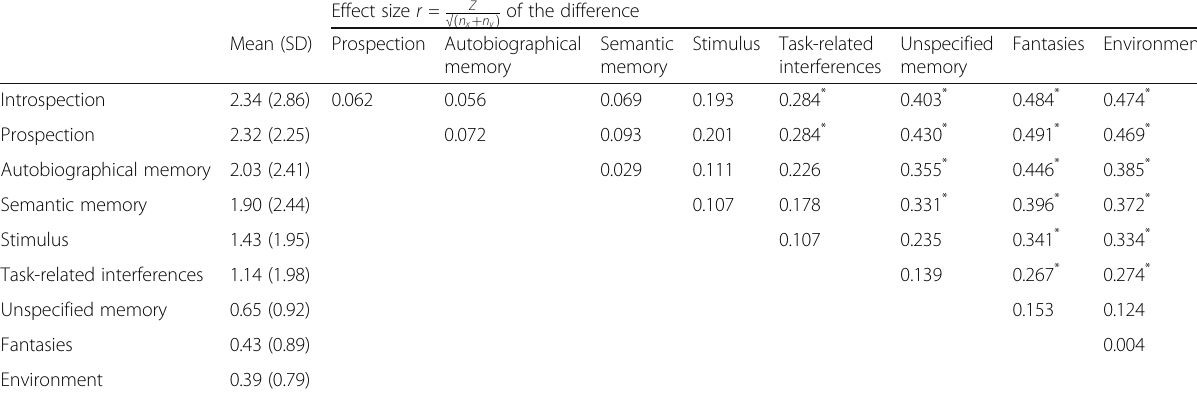
Table 2 Pairwise-comparisons between the frequencies of thought categories across participants using Wilcoxon ’ s signed rank test for paired